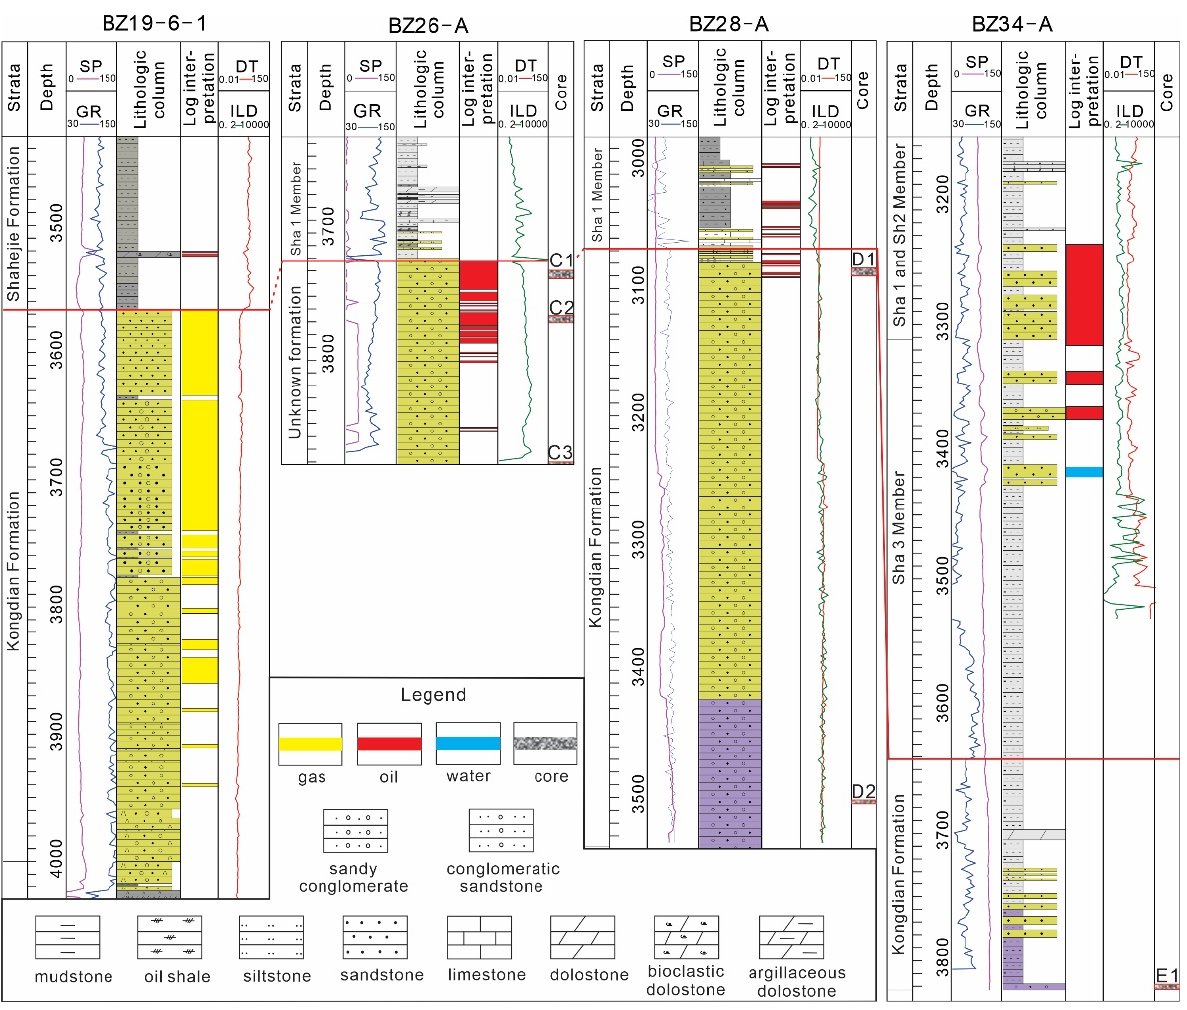
Figure 3. Stratigraphic section showing the borehole lithologies and the positions of sequence boundaries and core intervals.